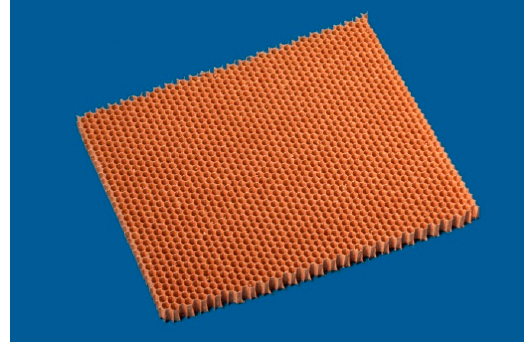
Figure 5. Aramid honeycomb C1-6.4-24 covered with phenolic resin.